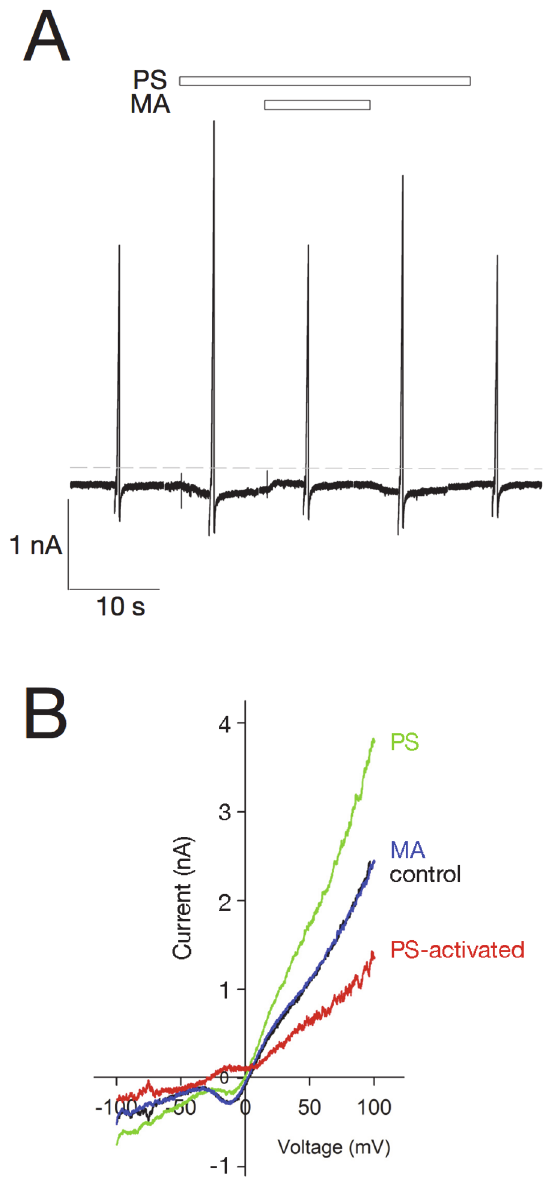
Fig 6. Pregnenolone sulfate activates a TRPM3-dependent outwardly rectifying current in isolated ganglion cells. Whole cell currents were recorded from isolated retinal ganglion cells. Holding potential was- 60 mV; near vertical current ramps were generated by a voltage ramp from-100 to +100 mV over 250 ms. A ) Time course illustrates activation of current by focal extracellular application of PS, and the subsequent inhibition by co-application of MA. B ) Current-voltage relation of currents from the cell shown in ( A ). The PS- activated current is PS-Control and displays strong outward rectification characteristic of